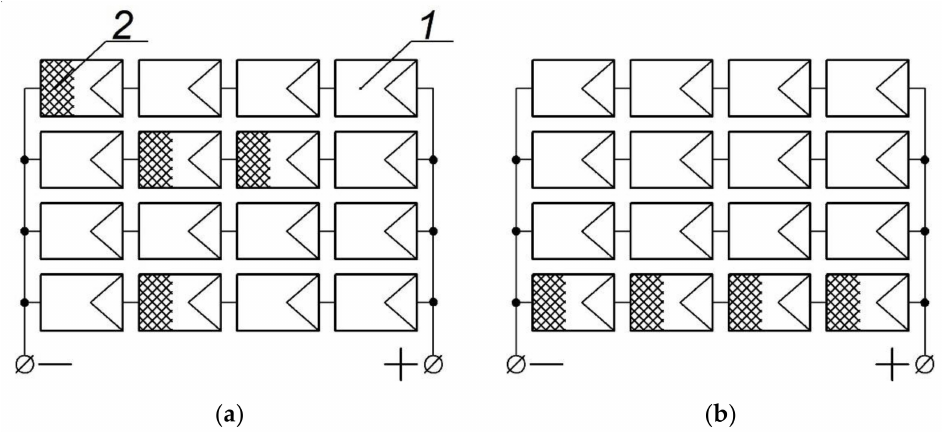
Figure 8. The operating principle of reconfigurable switching systems; ( a )—solar modules before commutation; ( b )—reconnected modules (1—normally lit module; 2—shaded